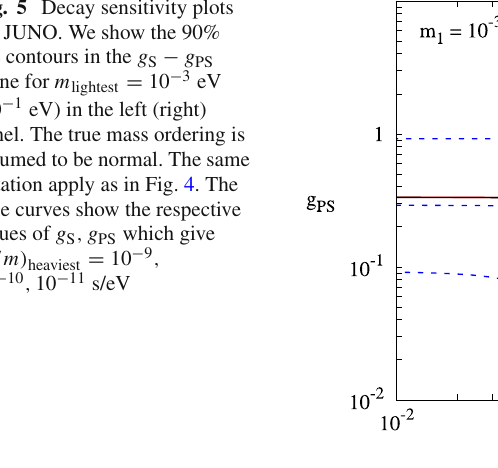
Fig. 5 Decay sensitivity plots for JUNO. We show the 90% CL contours in the g S − g PS plane for m lightest = 10 − 3 eV (10 − 1 eV) in the left (right) panel. The true mass ordering is assumed to be normal. The same notation apply as in Fig. 4. The blue curves show the respective values of g S , g PS which give (τ/ m ) = 10 − 9 , heaviest 10 − 10 , 10 − 11 s/eV